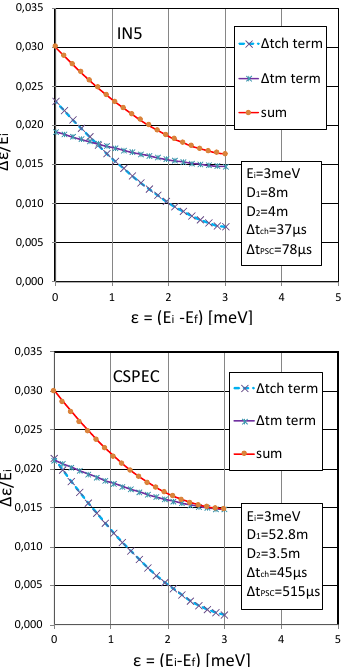
Fig. 6 Resolution diagram for the present optimization. Now the partial resolution regarding Δ t ch and Δ t m does not necessarily match at the elastic energy as seen in the panel of IN5, although that of CSPEC’s has negligibly small